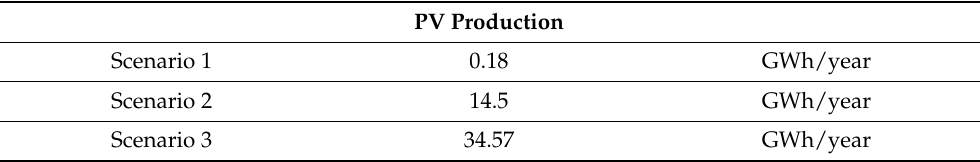
Figure 5. RES share in primary energy supply. Table 4. Results of modelling — energy generation from RES. Table 4. Results of modelling—energy generation from RES.